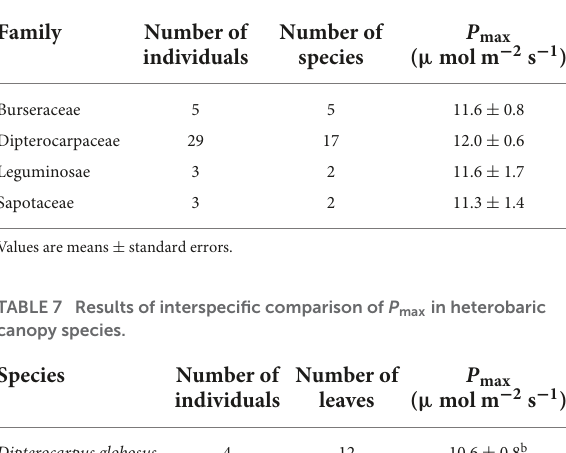
TABLE 6 Results of between-family comparisons of P max in heterobaric canopy species.